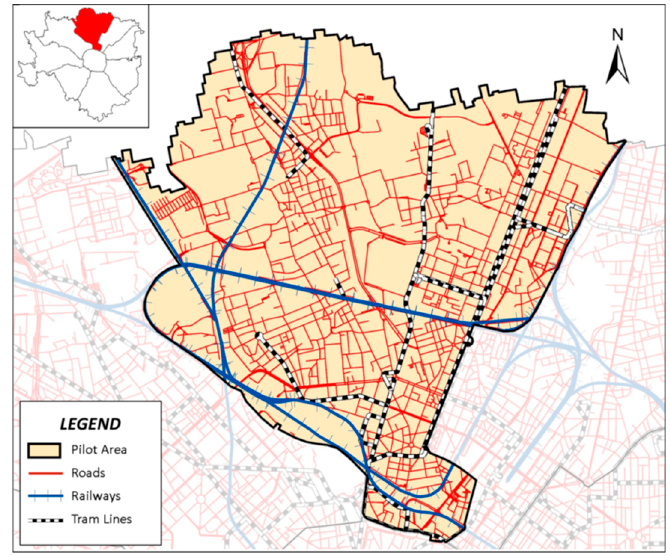
Figure 1. The Urban Zone 9 of the city of Milan, the pilot area chosen for the deployment of the acoustic sensors for Dynamap. The number of recording stations has been fixed at 24.